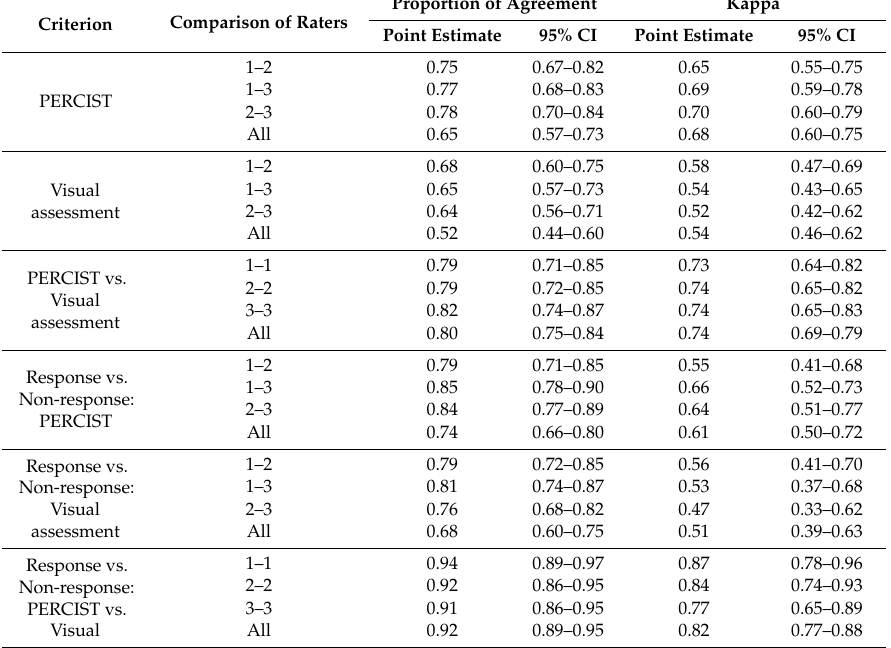
Table 1. Summary of agreement and reliability